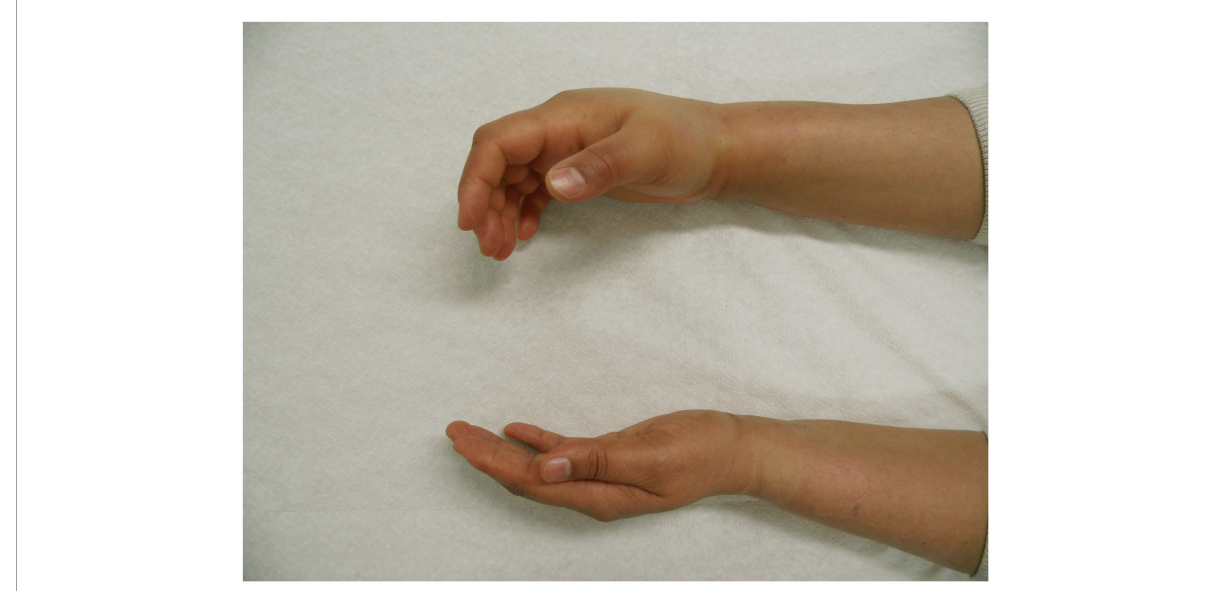
FIGURE1 Angioedema of the right hand in a patient with hereditary angioedema due to C1 inhibitor (C1INH) deficiency (HAE-C1INH). Patient consent was